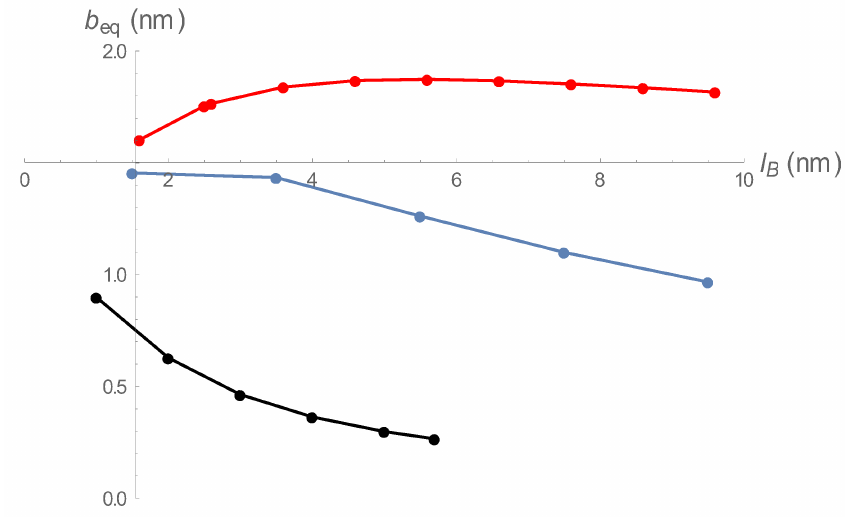
Figure 6. An illustration of the three ways that condensed counterions can affect contraction of the bead-spring chain: t = 0 nm − 2 (red), t = 4 nm − 2 (blue), t = 50 nm − 2